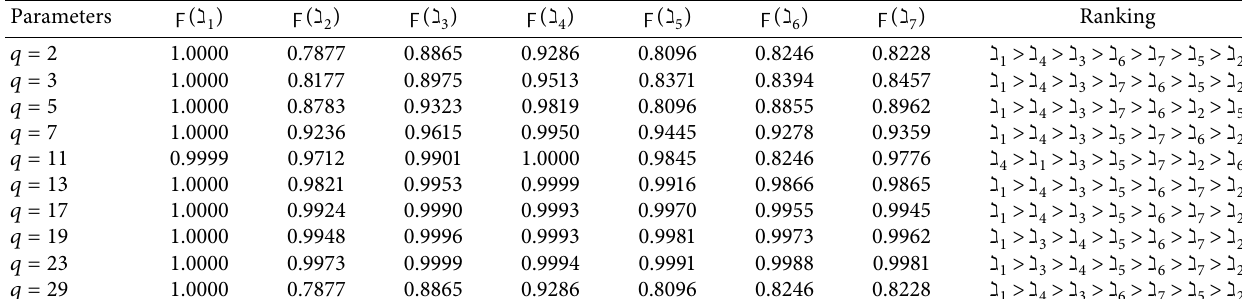
Table 11: Score values and ranking outcomes according to the parameter q by the 2TLC q -ROFHWA operator.